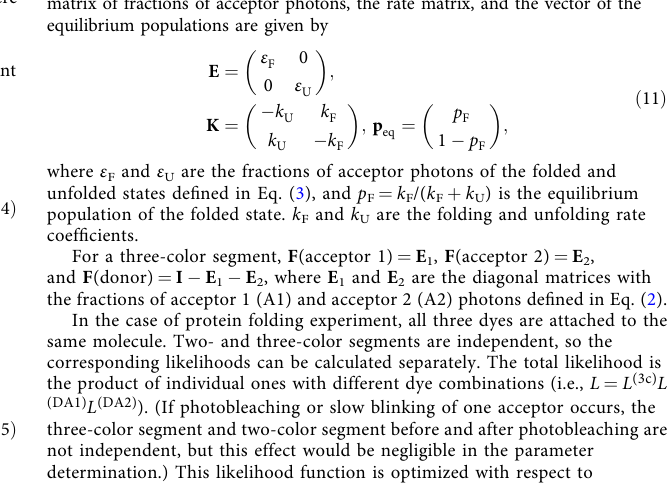
where N is the number of photons in a trajectory, and c i and t i are the color and arrival time of the i th photon. K is the rate matrix, the photon color matrix F depends on the color c of a photon as de fi ned below for the two- and three-color cases. 1 T is the unit row vector (T means transpose), and p eq is the vector of equilibrium populations. The parameters were determined by maximizing the likelihood function calculated by diagonalizing K 22 . Practically, the total log- likelihood function of all trajectories was calculated by summing individual log- likelihood functions in Eq. (10). In the calculation of the likelihood function for a two-color segment with fl uorescence of donor and one of the two acceptors in protein folding experiment, the photon color matrix is F (acceptor) = E and F (donor) = I − E , where E is a diagonal matrix with the fractions of acceptor photon count rates of the individual states on the diagonal and I is the identity matrix. For the two-state model, the matrix of fractions of acceptor photons, the rate matrix, and the vector of the equilibrium populations are given by